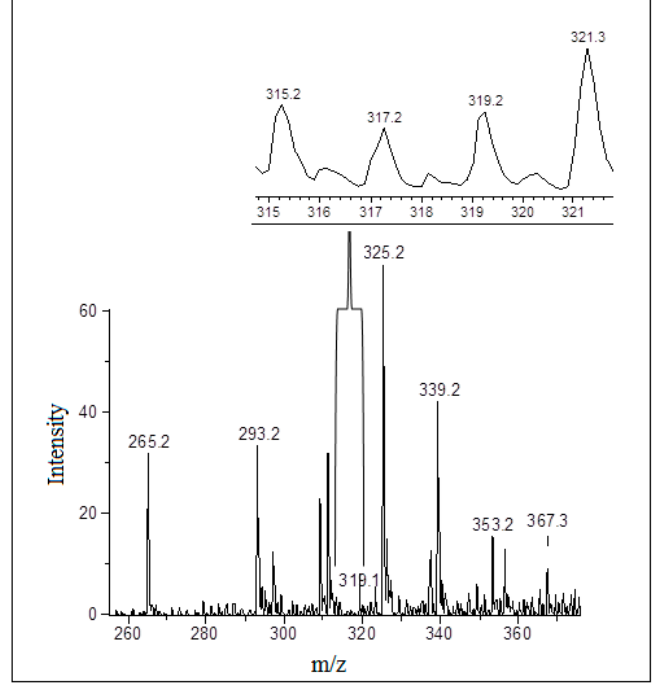
Figure 5. Detection of oxidized polyunsaturated fatty acid from ESI-MS spectra of FC1 T180 sample at m / z range of 250–400 in negative ion mode. Precursor ions of m / z 293, 295, 317 and 319 are characteristic peaks for oxidation of linoleic and arachidonic acids.